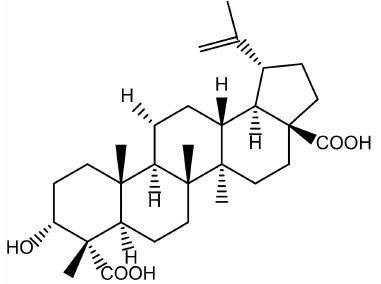
Figure 9. The chemical structure of